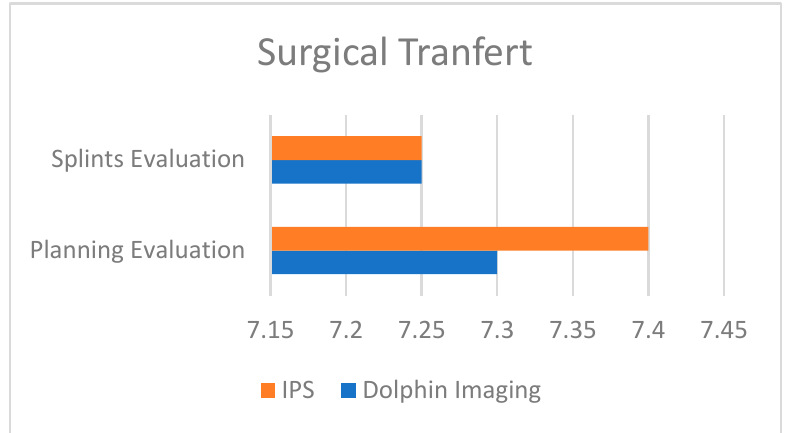
Figure 1. Evaluation of the surgical transfer.